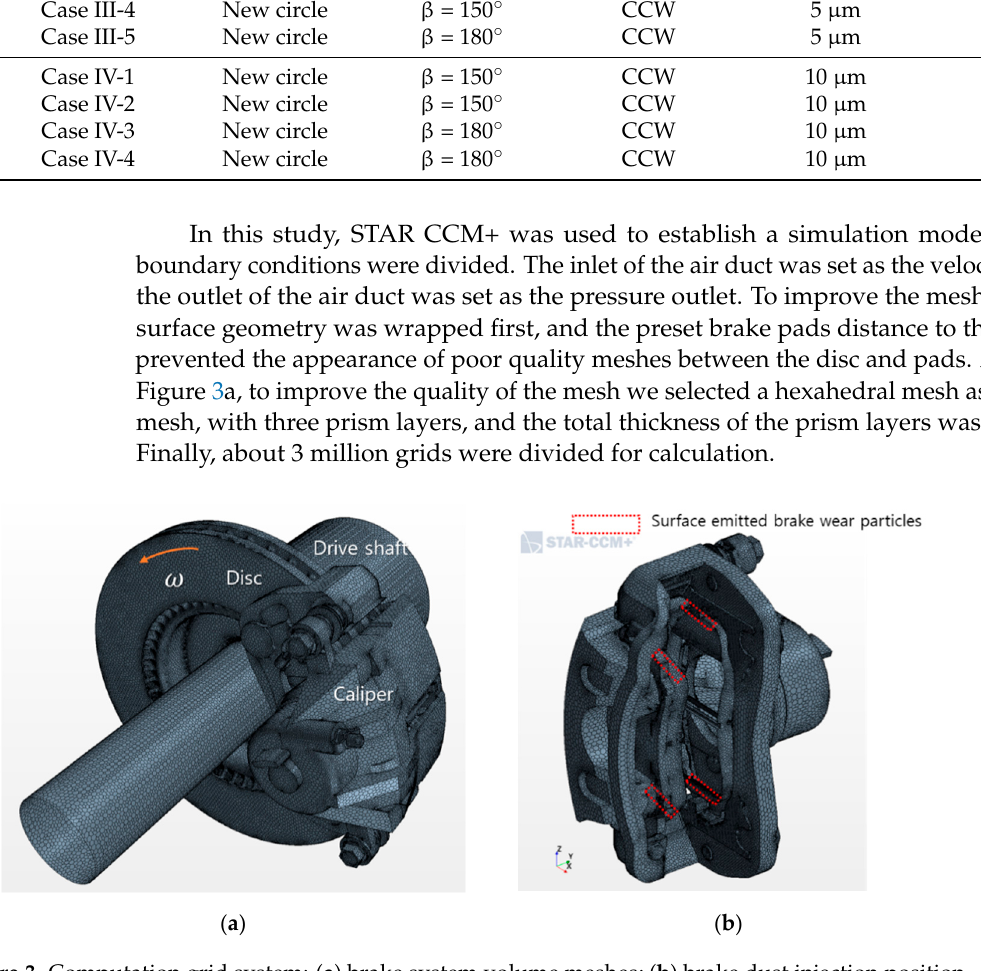
Figure 3. Computation grid system: ( a ) brake system volume meshes; ( b ) brake dust injection position.